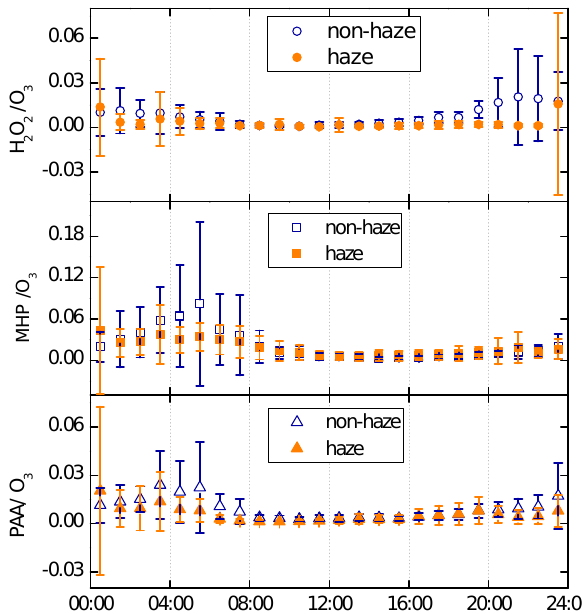
Fig. 6. Hourly-averaged ratio of peroxide to O 3 on non-haze and haze days. The error bar represents the standard deviation (1 σ ) of the 1h average